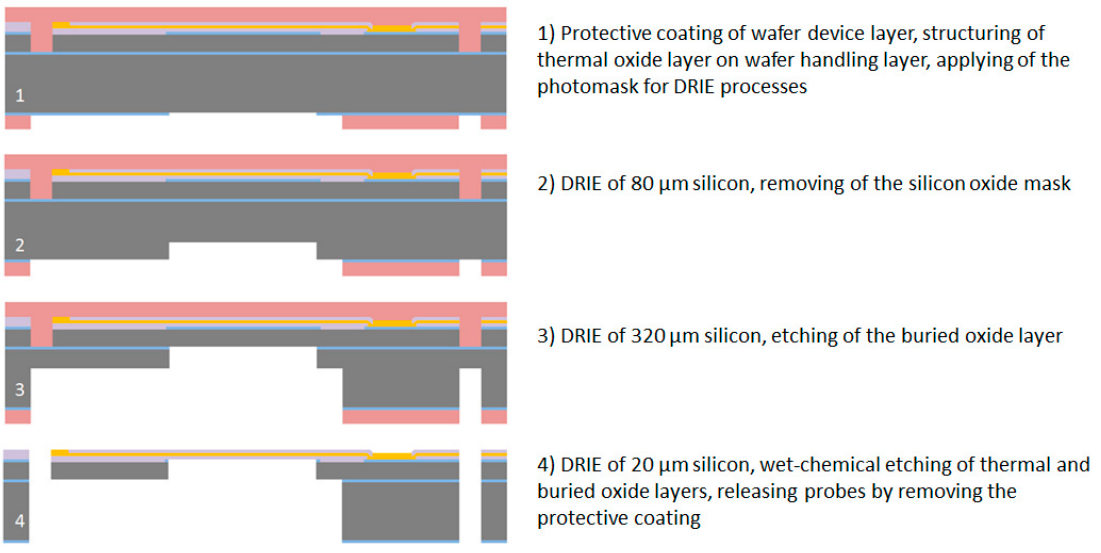
Figure 4. Cross section view of the microfabrication process flow for the wafer handling layer.